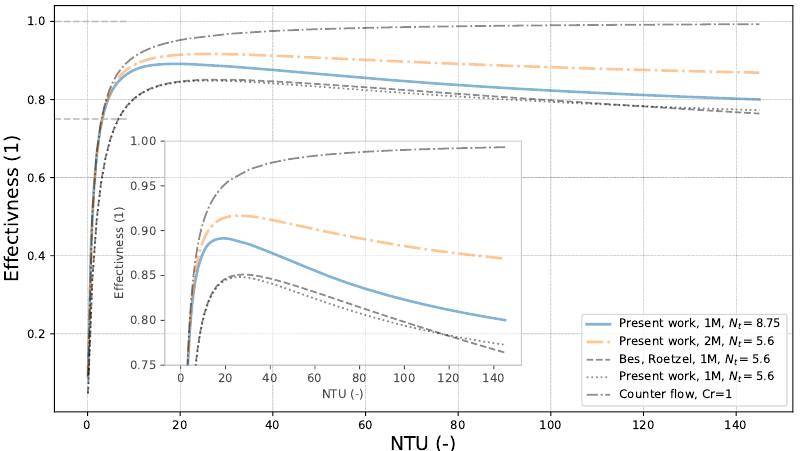
Figure 7. Comparison of the predicted effectiveness parameter for one- and two-module SPHE. 2M, N t = 5.6 is equivalent to 1M, N t = 8.75 SPHE.